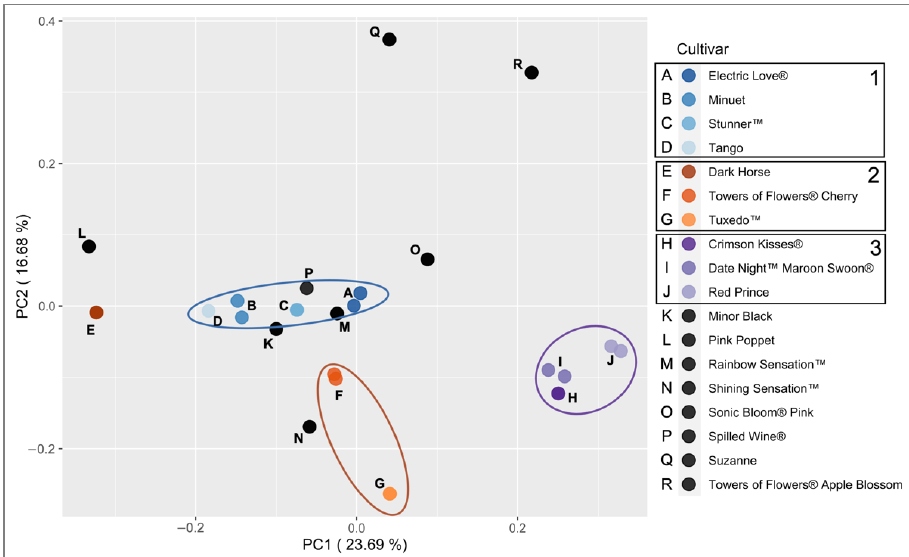
Figure 4. Principal Coordinate Analysis (PCoA) across 18 Weigela cultivars using Bruvo’s distance. Percent variance explained for each principal coordinate is listed in the axis label. All cultivars are labeled with letters. Cultivars within identified breeding groups are represented by colored dots. Cultivars in Group One are denoted by shades of blue; Group Two shades of orange; and Group Three shades of purple. Individuals with no deducible breeding group are denoted by black dots. Note individual cultivar samples that are different (i.e., ones where two circles are visible) only vary in the amount of missing data, not alleles — all allele sizes were within four bp of each other, so they were manually corrected before being binned into statistical allelic classes.